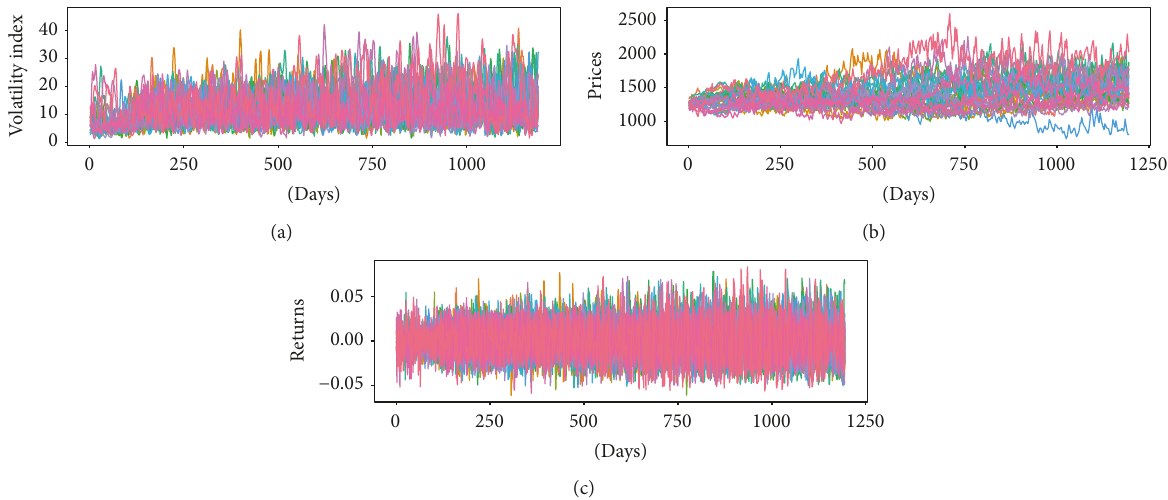
Figure 9: Time series of volatility index (a), prices (b), and returns (c) when 𝑔 = 2 = 0 and 𝑔 = 1 = 𝑔 = 3 = 0 .